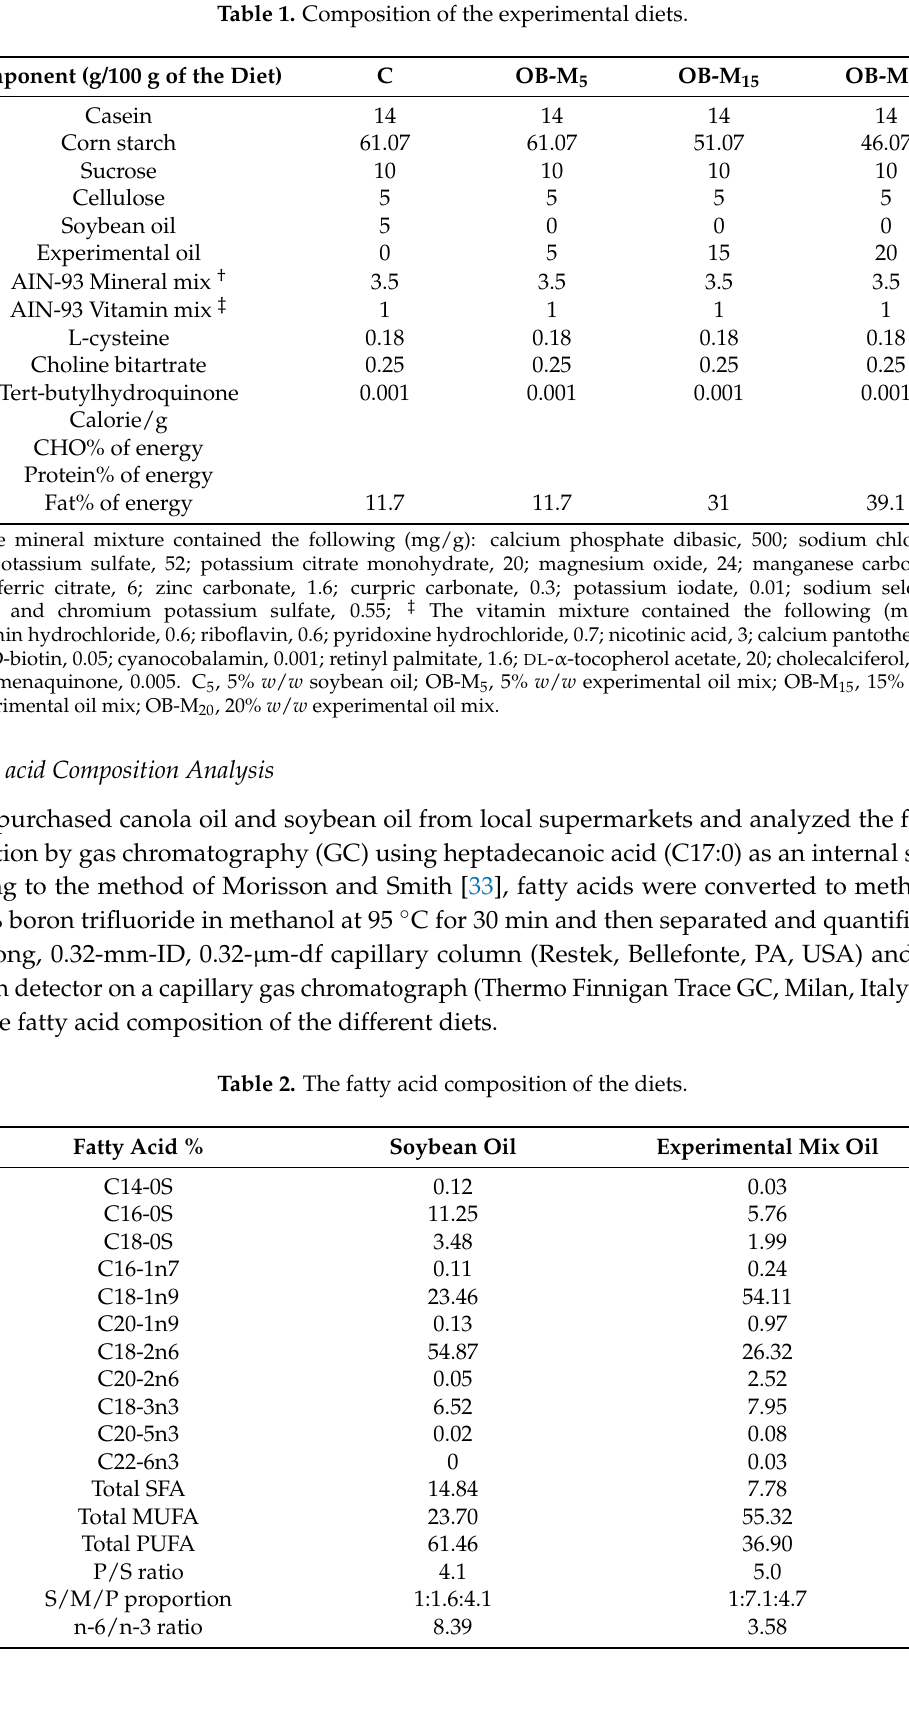
Table 1. Composition of the experimental diets.